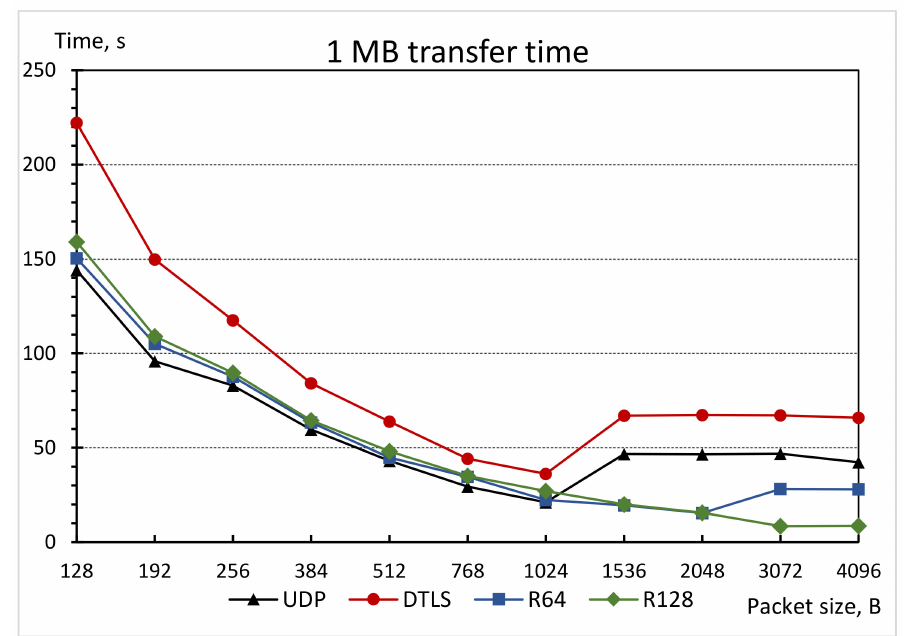
Figure 6. Comparison of time needed to transfer 1 MB of data using di ff erent transport protocols.